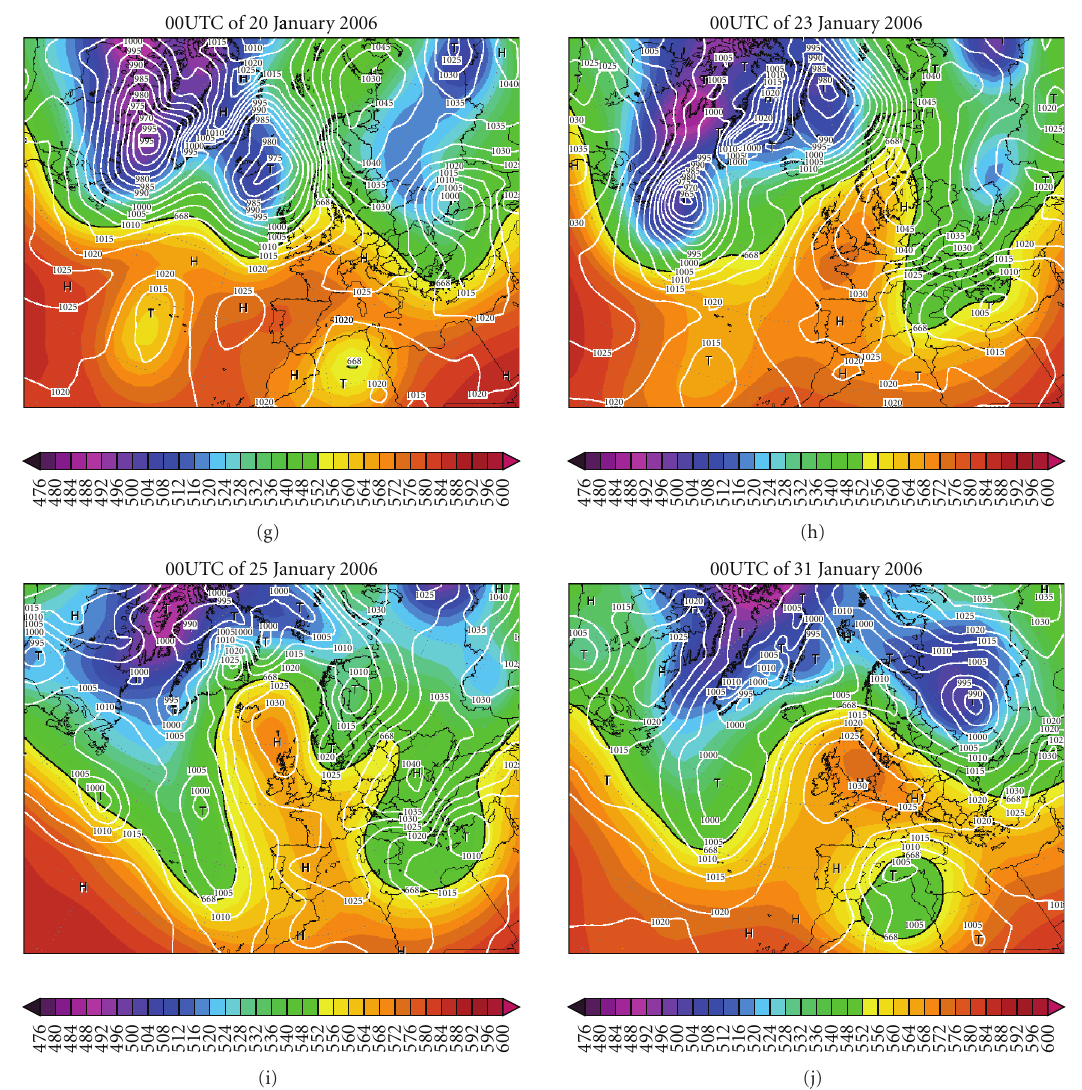
Figure 2: Geopotential height (shaded) at 500 hPa level (gpdm) and mean seal level pressure (contours) during the period 1-31 January 2006 from NCEP 2.5 degree reanalysis data.